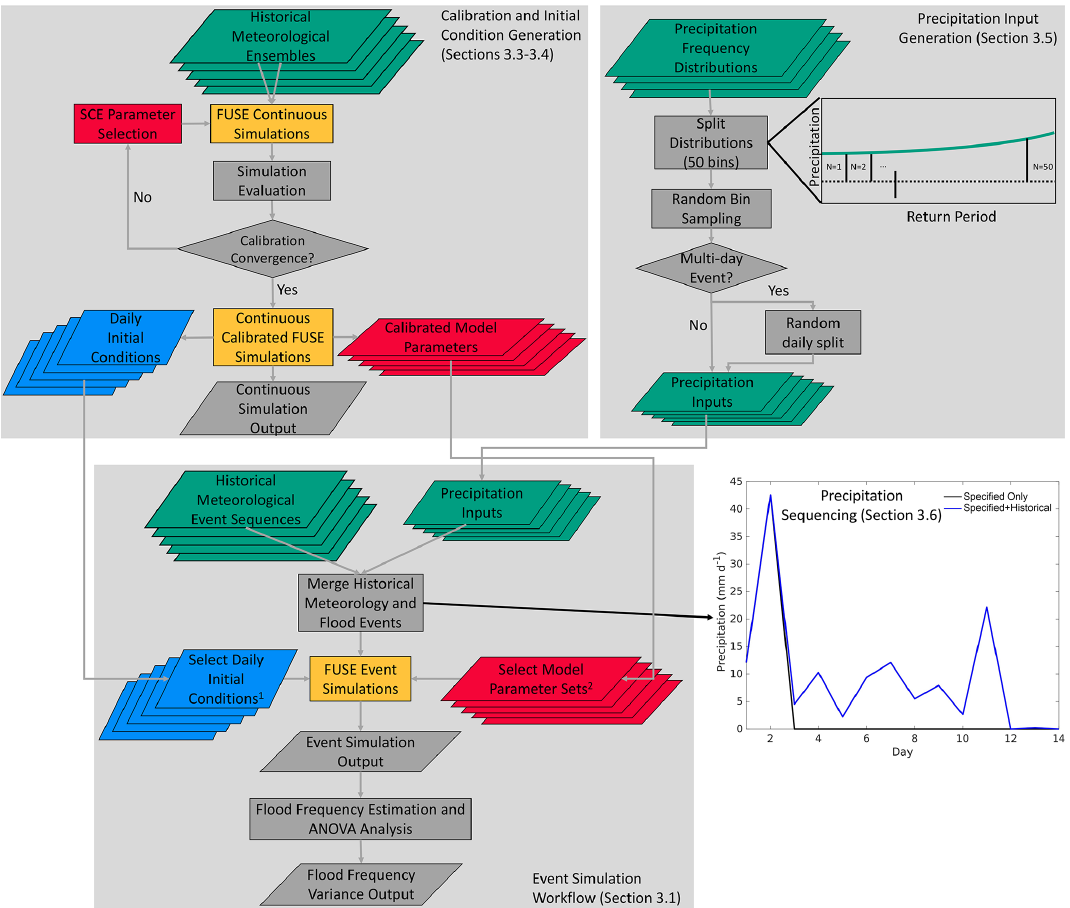
Figure 3. Workflow diagram of the complete stochastic modeling system described in Sect. 3. The calibration, initial condition generation, and precipitation-input-generation steps are shown in more detail in the upper two gray panels, which then feed to the lower right gray panel. Merging of the flood event precipitation, with specified 0 precipitation days or historical meteorology, is show in the lower right figure. Color coding follows Fig. 1. 1 Select daily initial conditions are matched for a given model and parameter set and are taken as the 90th, 94th, 97th, and 99th percentile of total column moisture for that model and parameter set combination. 2 Select model parameter sets are taken as the top-performing model parameter sets from the 100 available calibrations for each model structure for each basin, following Sect.